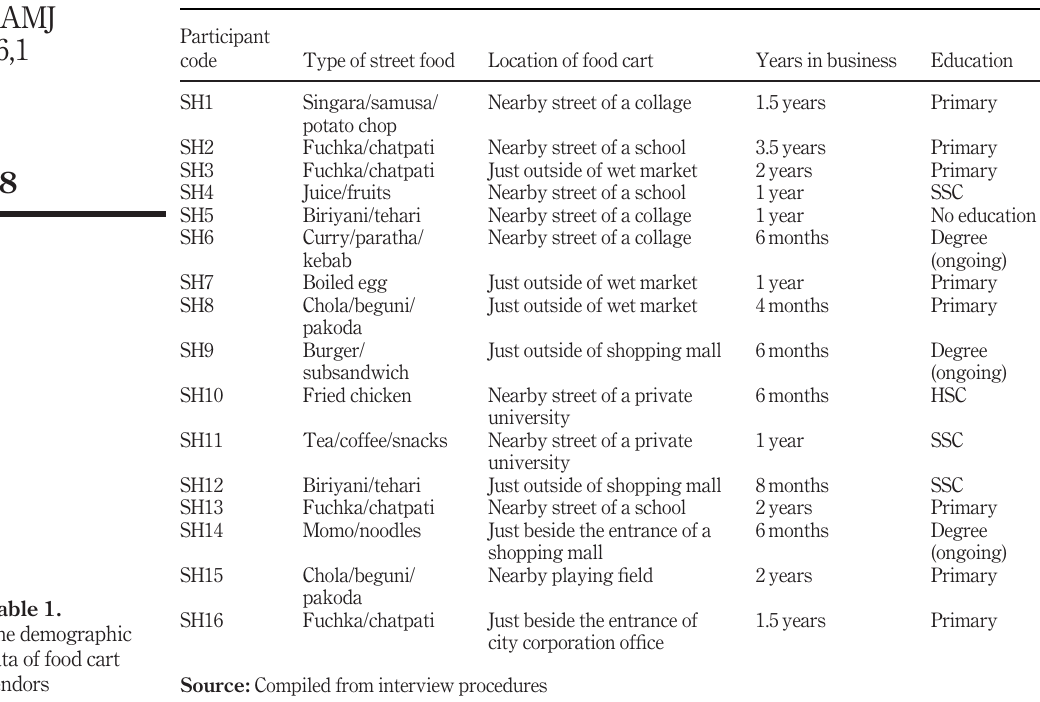
Table 1. The demographic data of food cart